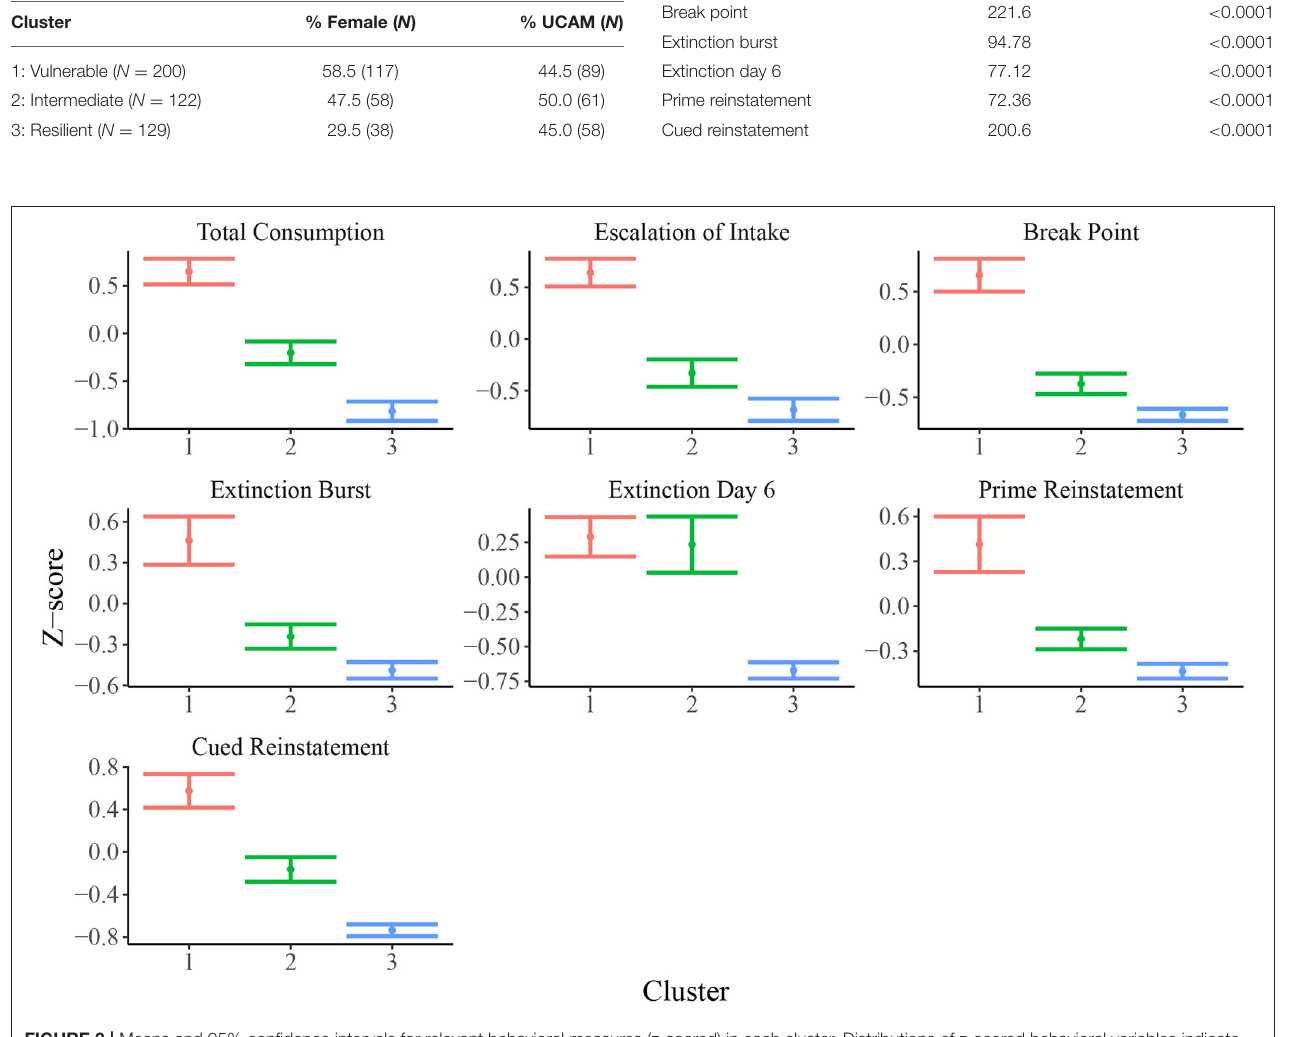
200), intermediate (cluster 2; N 122), and resilient (cluster 3; N 129) sub-populations. = = =